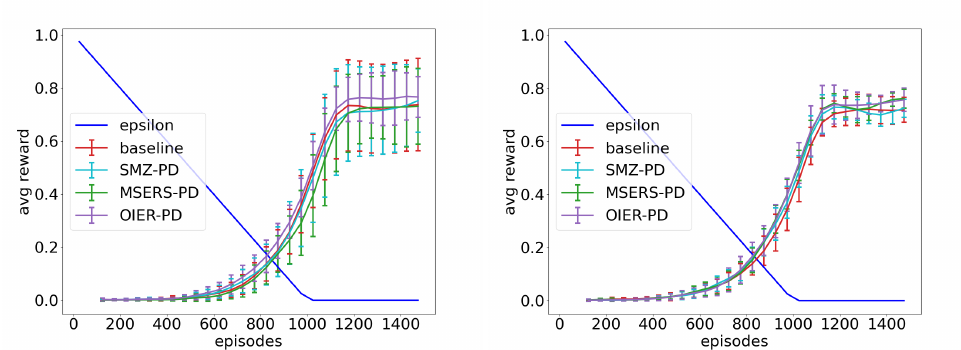
Figure A8. The results for the IER mode: PD and t expl = 1000. state encoding: VE. state encoding: CE.